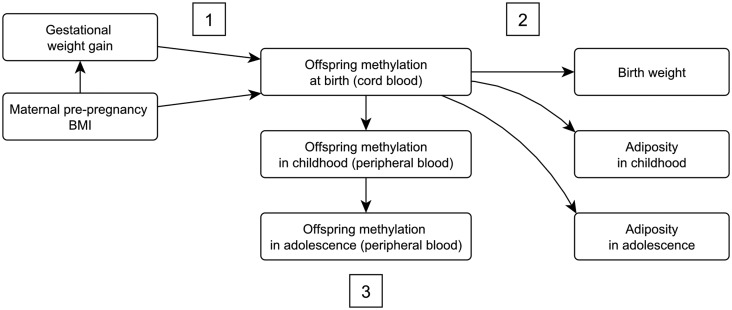
A conceptual framework showing the relationships of interest. GWG and maternal BMI are hypothesized to affect offspring adiposity via offspring DNA methylation. Specific hypotheses are: (i) maternal pre-pregnancy BMI and/or GWG is associated with differential methylation at CpG sites in offspring cord blood; (ii) methylation at these sites is also associated with offspring adiposity (we would also expect consistency between different measures of adiposity and age at measurement); and (iii) maternal adiposity is persistently associated with differential methylation in offspring at time points beyond birth.